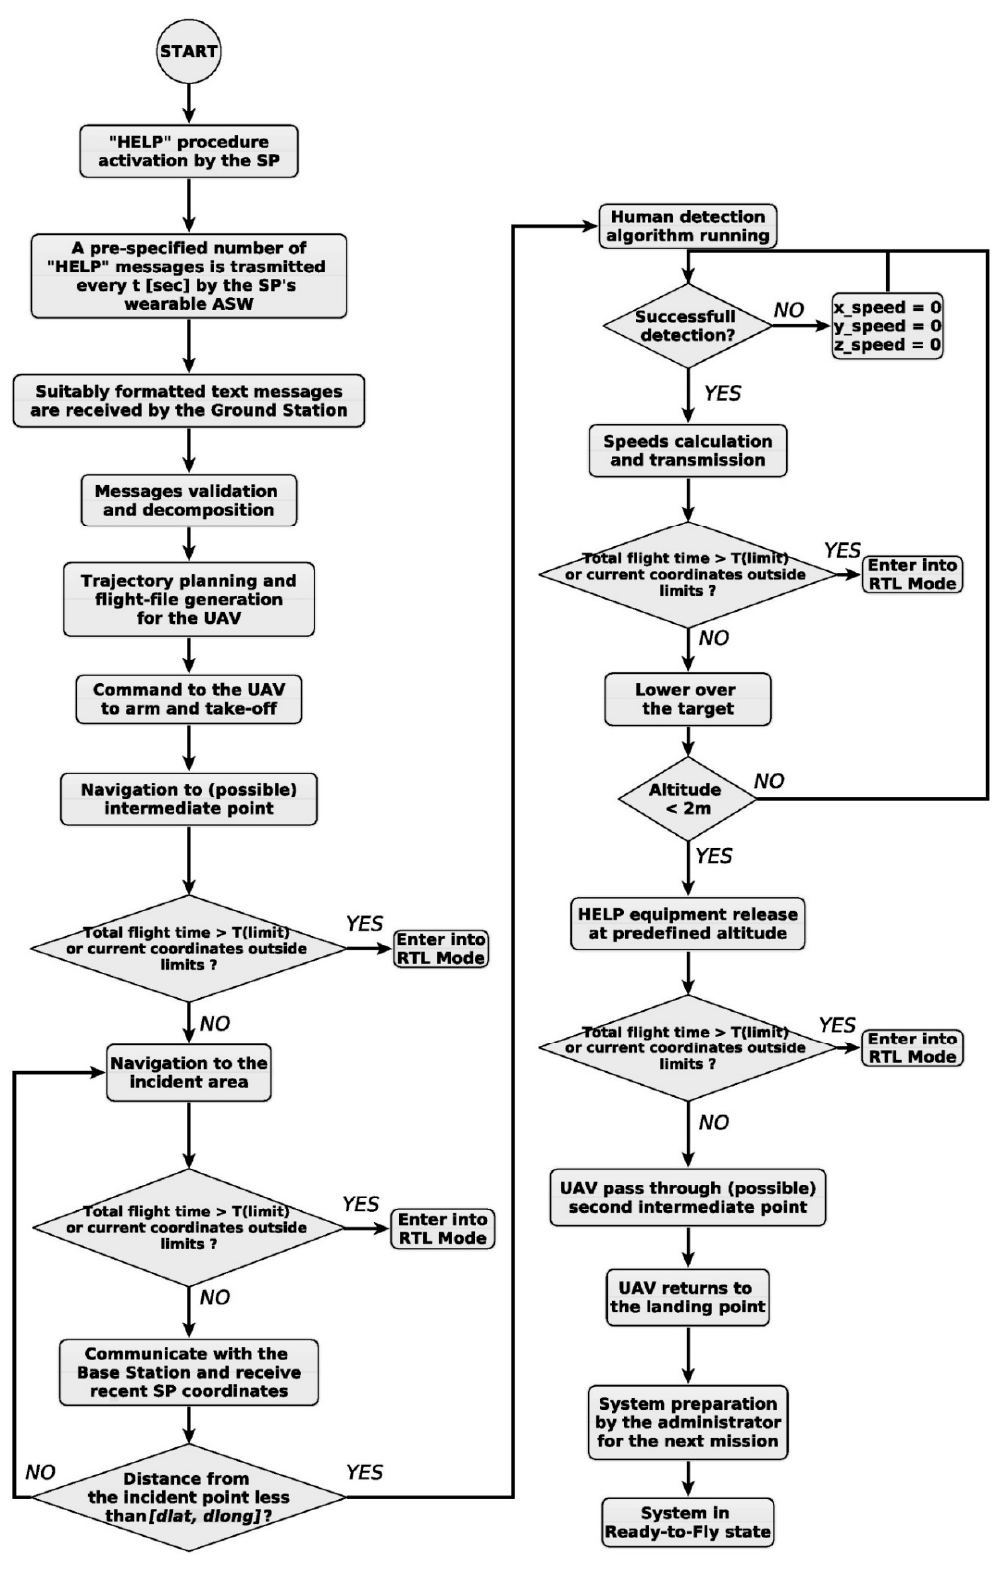
Figure 7 . Autonomous Rescue System’s Operation Flowchart. Figure 7. Autonomous Rescue System’s Operation